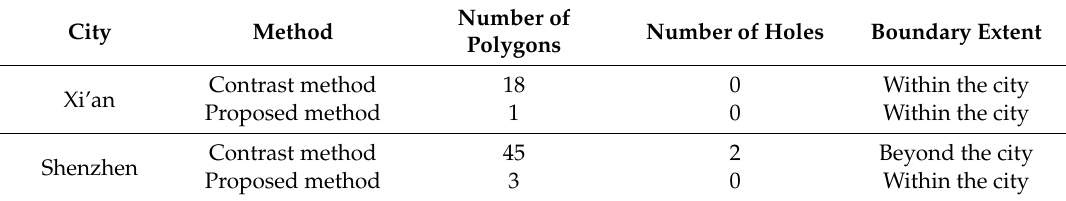
Table 1. Characteristics of the recognized results by two methods in two cities.